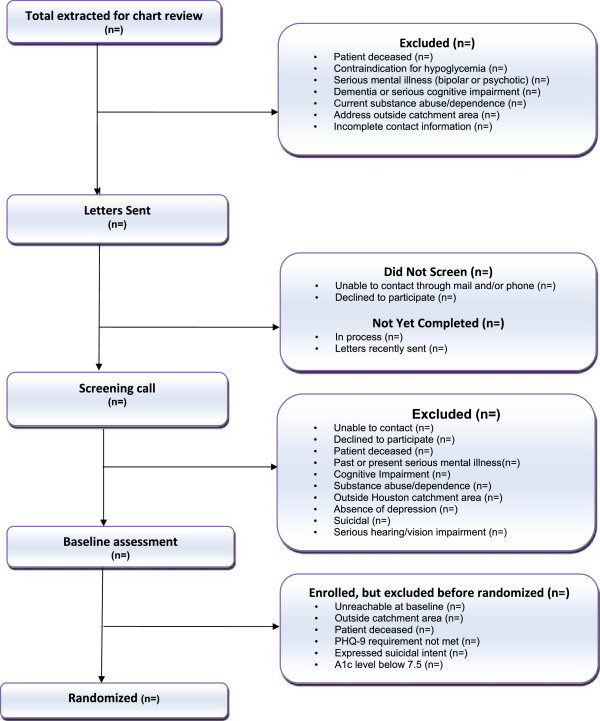
Consort diagram.